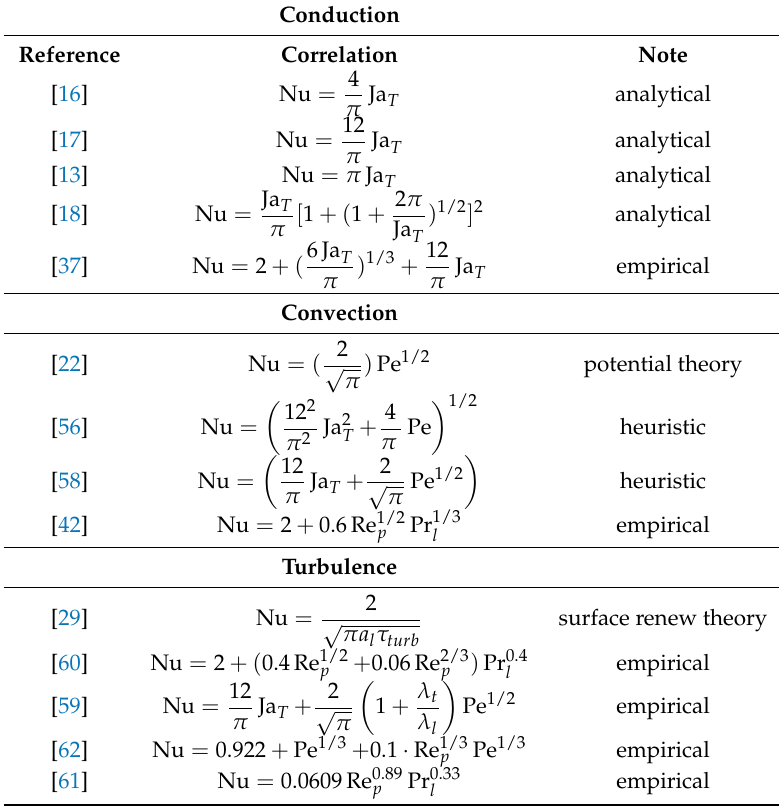
Table 1. Correlations for estimating interphase heat transfer